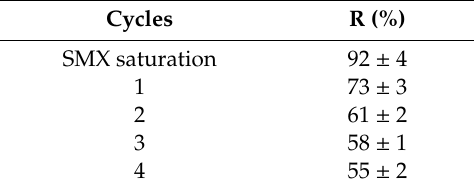
Table 6. SMX adsorption onto MY@MIPs in subsequent cycles after regeneration.